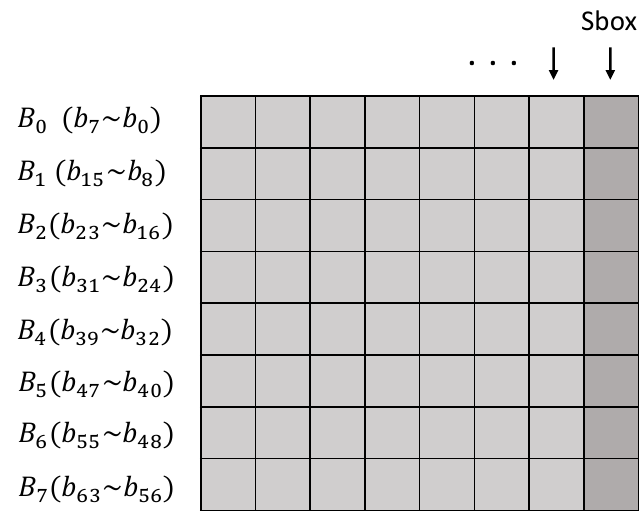
Figure 2. Substitution layer structure of PIPO.